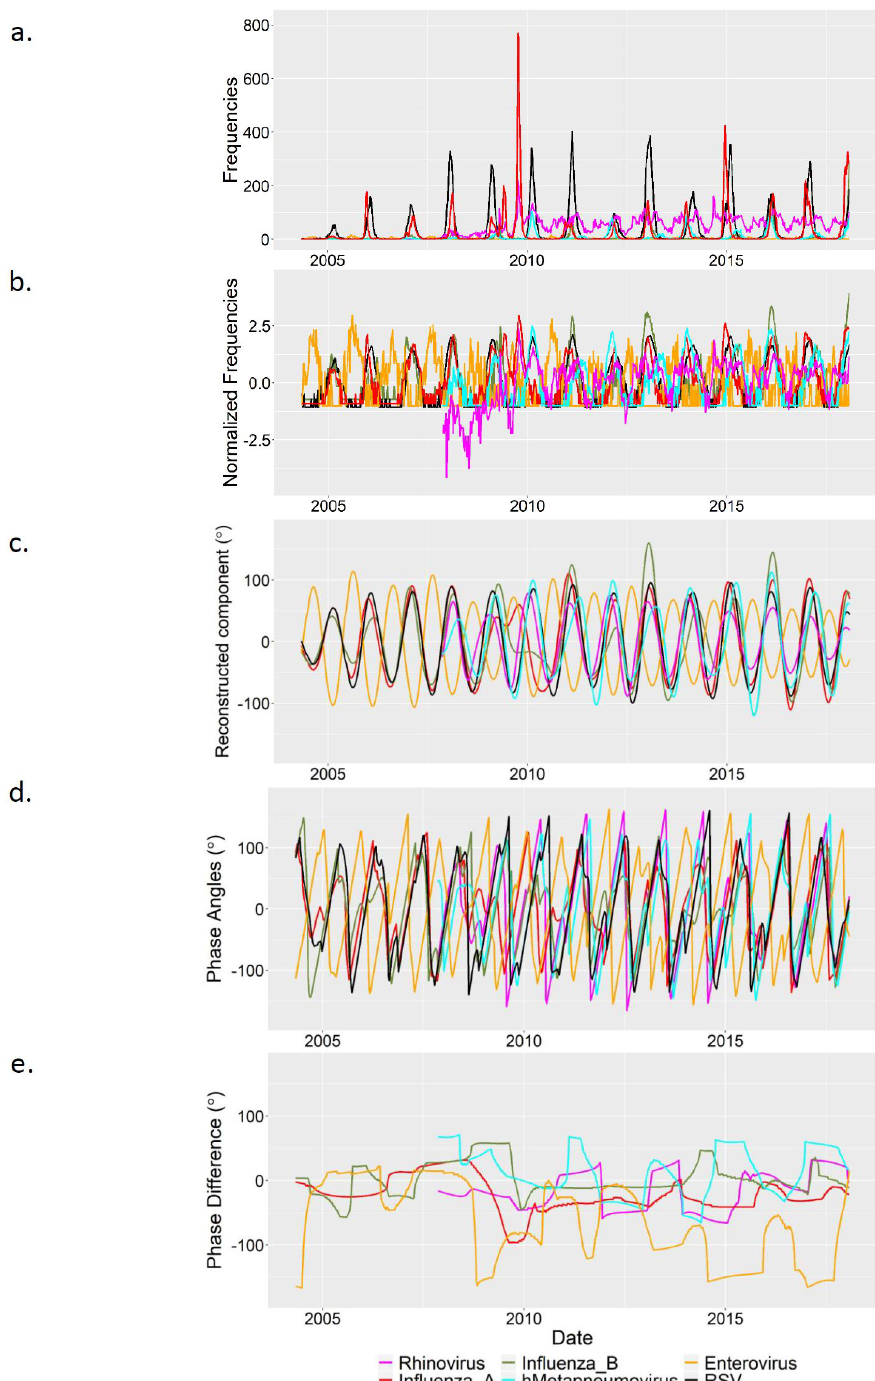
Figure A3. Wavelet analysis of positive viral samples from 2004 to 2018: ( a ) Raw frequency data. ( b ) Normalized frequencies. ( c ) Reconstructed component from wavelet analysis, using periods 32–65 for Rhinovirus, Metapneumovirus, RSV, and Enterovirus, and 32–108 for influenza A and B. A loess smoother was applied to rhinovirus, to correct for an increase in testing during 2007–2008. ( d ) Phase angles using the aforementioned periods. ( e ) Phase differences between each virus and RSV. Lines at zero indicate phase synchrony. Lines deviating from zero indicate the epidemics are not in phase.